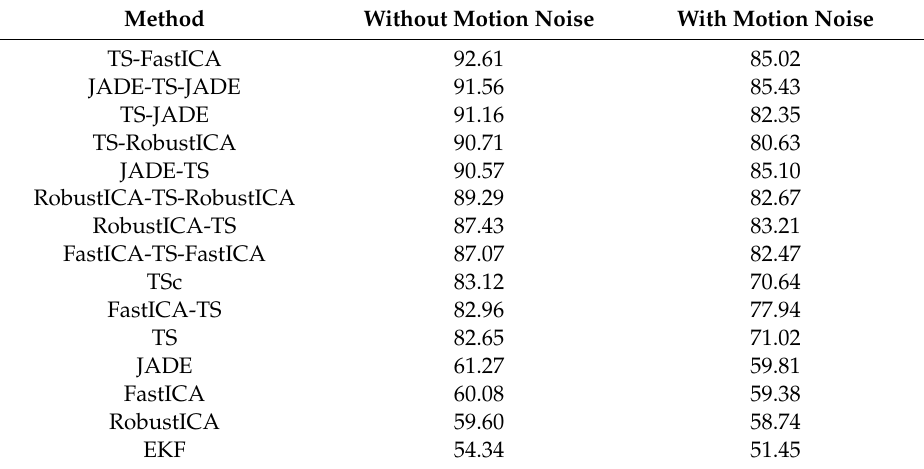
Table 1. Average F1 score (%) with di ff erent methods for all